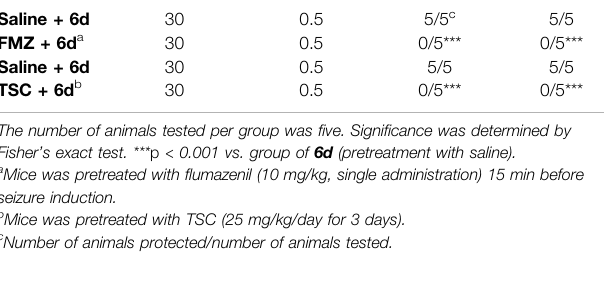
TABLE 5 | Effects of fl umazenil (FMZ) and thiosemicarbazide (TSC) on the anticonvulsive action of 6d against MES and PTZ-induced seizures in mice. Compound